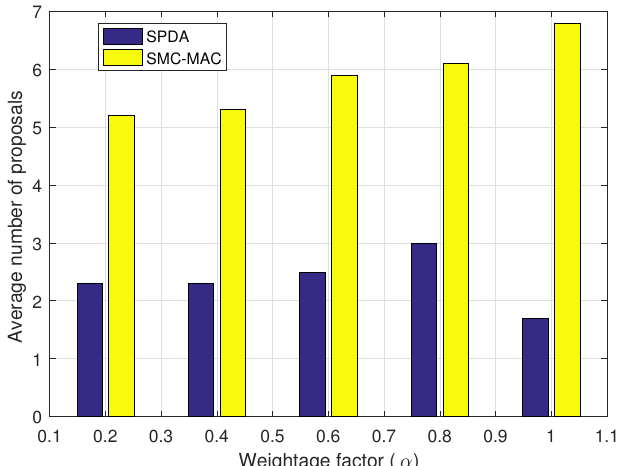
Figure 10. Average number of proposal with variation in the weightage factor, ( α